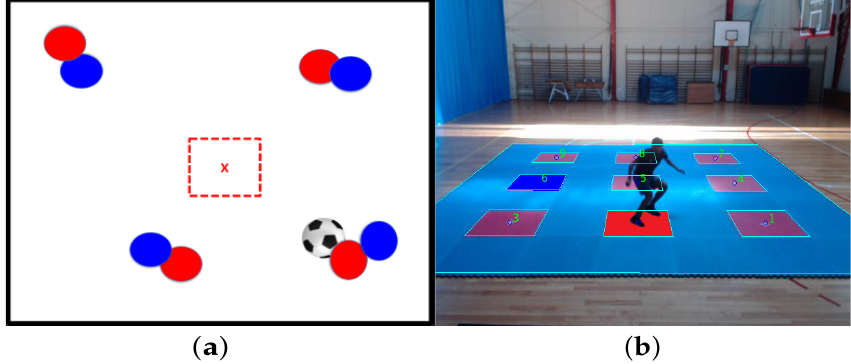
Figure 10. Mistaken target match according to visual stimulus. ( a ) Visual tactical soccer situation. ( b ) Mistakenly matched target according to the stimulus.